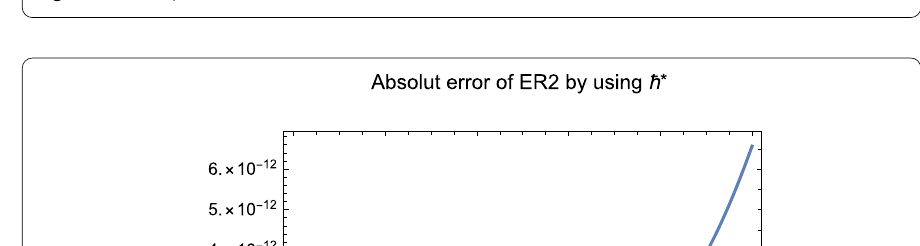
Figure 14 The optimum and minimum values of X ( t )